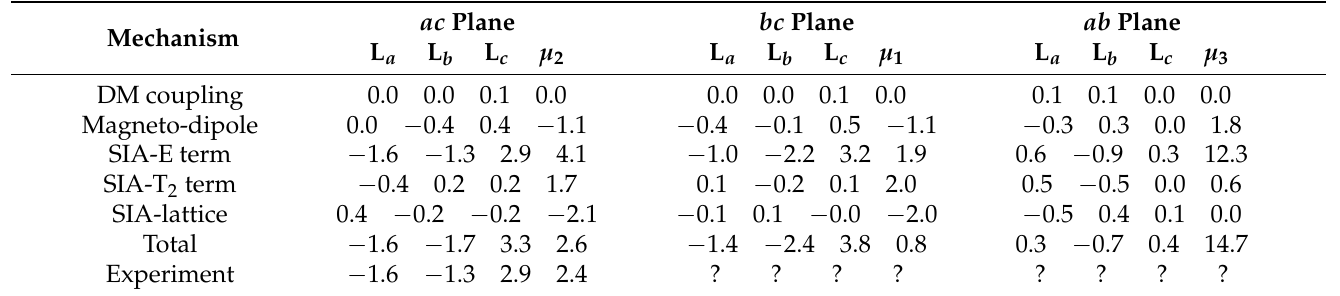
Table 6. Contributions of the main mechanisms to the magnetostriction constants for YFeO 3